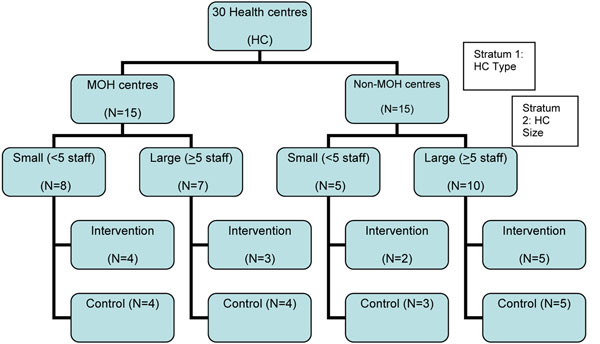
Randomization Flow ChartHC type: Non-MoH (Ministry of Health) facilities are either mission or institutional facilities. HC size: Small health centre have < 5 staff; large health centres have >5 staff